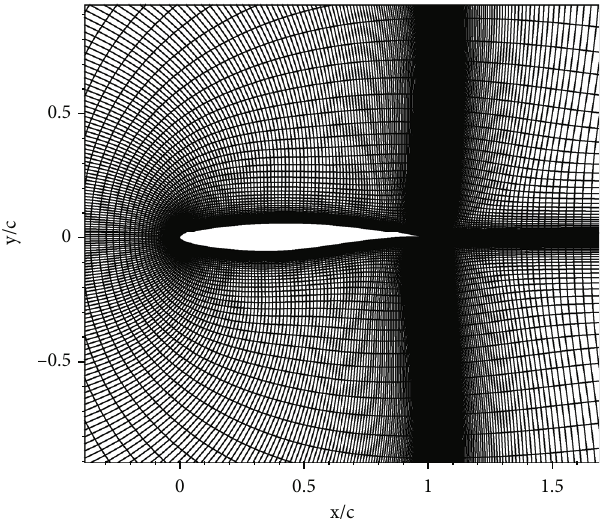
Figure 14: The computational grid of RAE 2822.